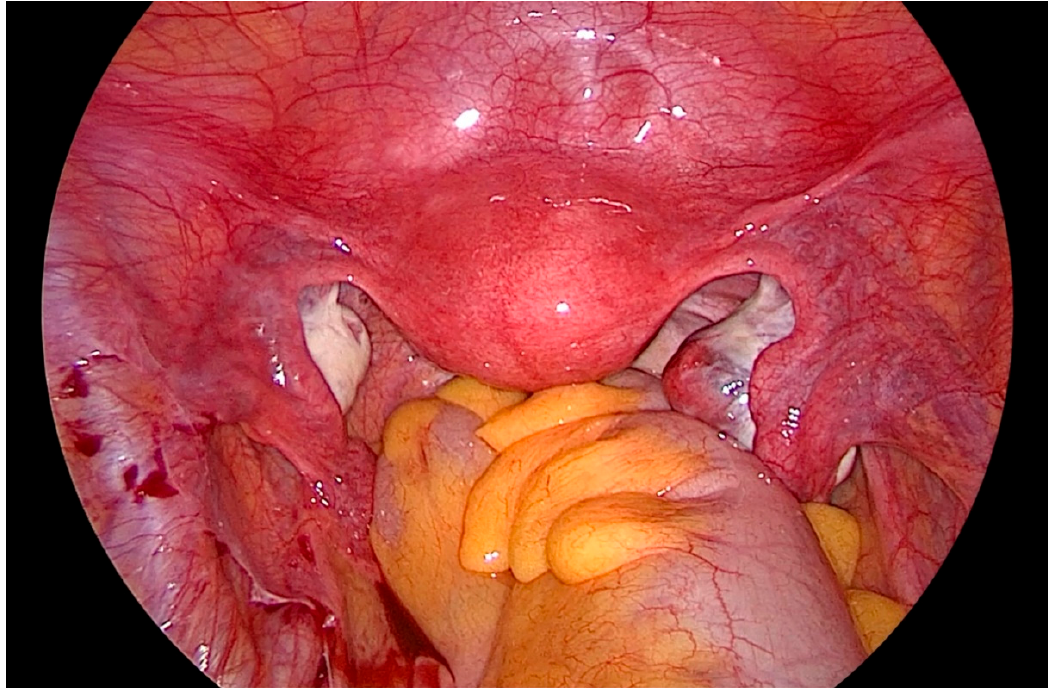
Figure 1. Laparoscopic view of the pelvis, depicting the ovaries hampering vision and access to the lateral pelvic wall.